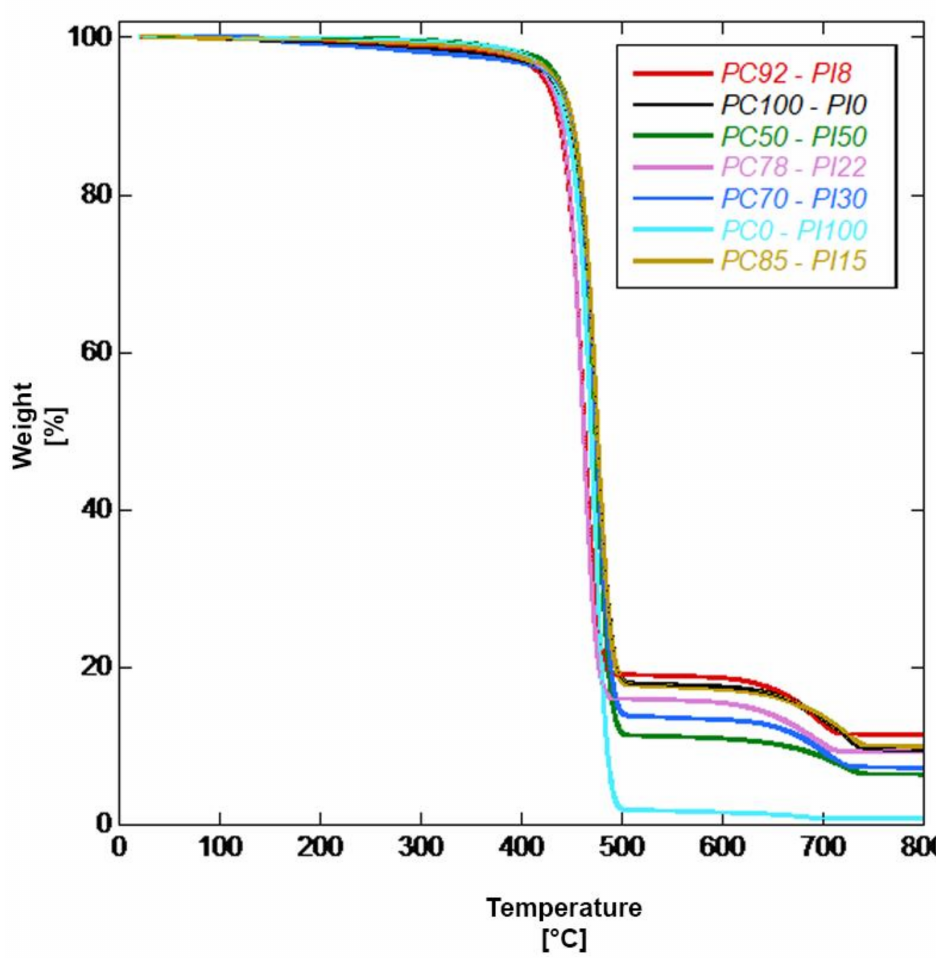
Figure 8. Weight loss versus temperature for all